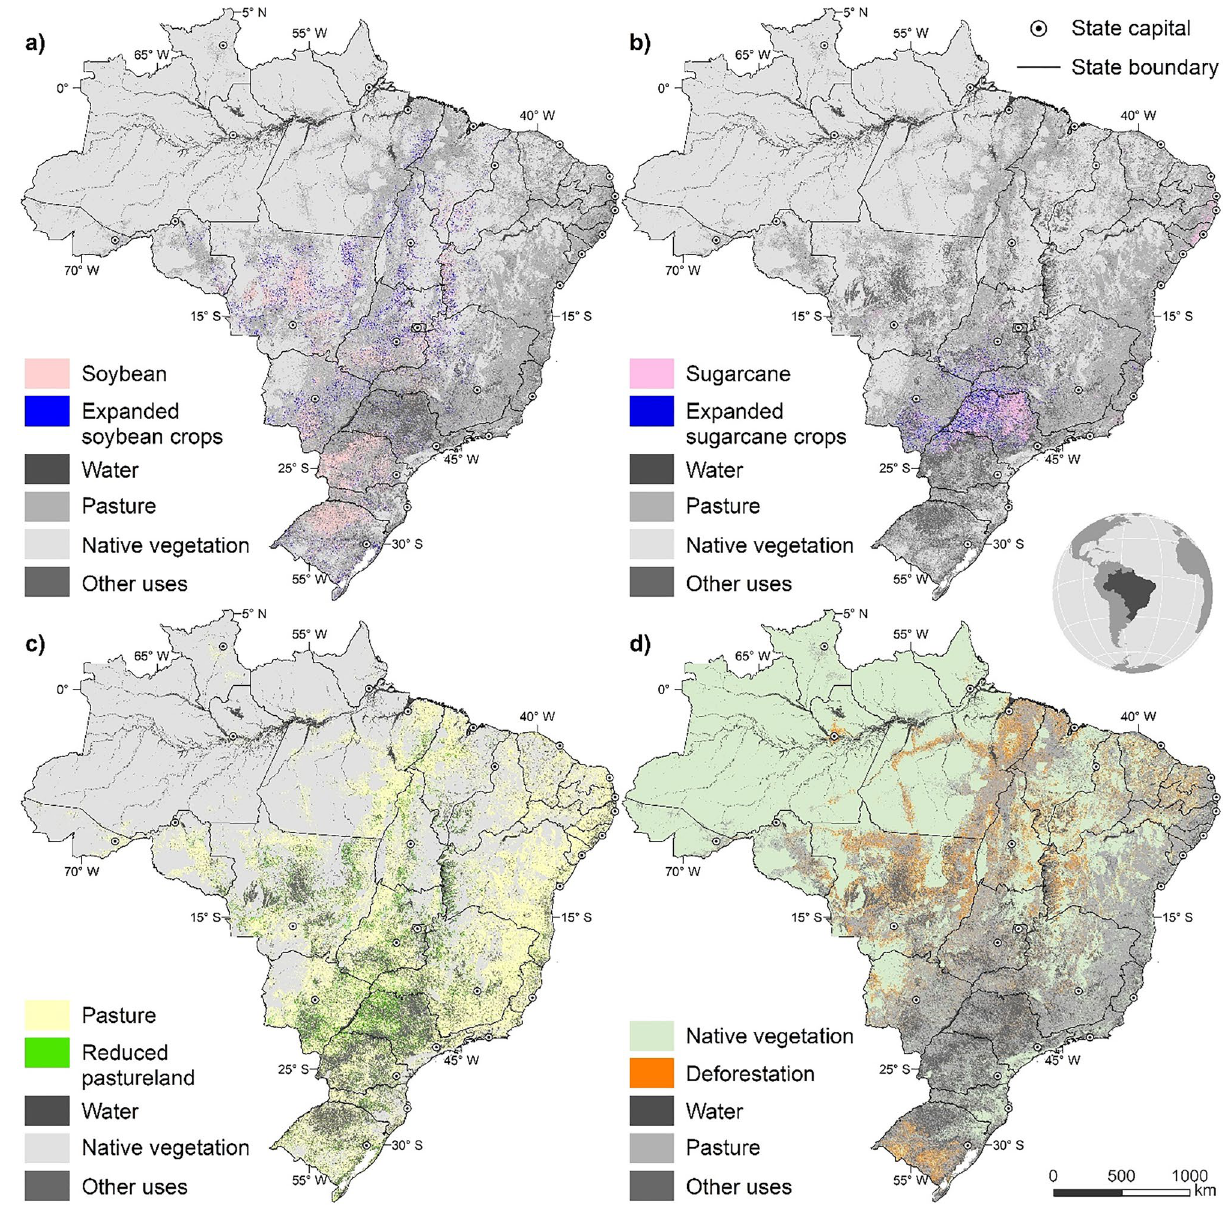
Figure 1. Major land-use transitions. ( a ) Large-scale soybean expansion will take place in the Midwest and Southern Amazon. ( b ) Sugarcane will continue expanding mainly onto pasturelands in the southeast. ( c ) Long-established pasturelands in the Midwest will shrink due to crop expansion. ( d ) Deforestation will advance toward northern regions. Map created using Dinamica EGO 5 (https:// dinam icaego.